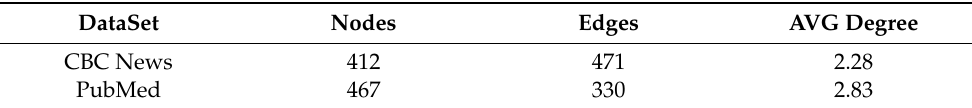
Table 2. Describes the structural properties of the network training models generated from two different datasets. DataSet Nodes Edges AVG Degree CBC News 412 471 2.28 PubMed 467 330